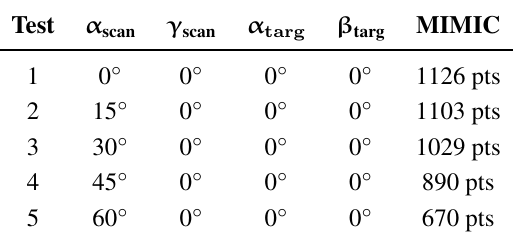
Table 1. The impact of horizontal scanner rotations on the number of pulses striking a parallel 2 m × 1 m target at a horizontal range of 5 m.